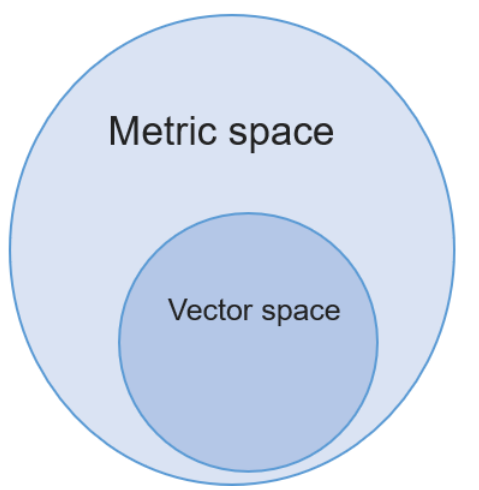
Figure 1. Vector space vs. metric